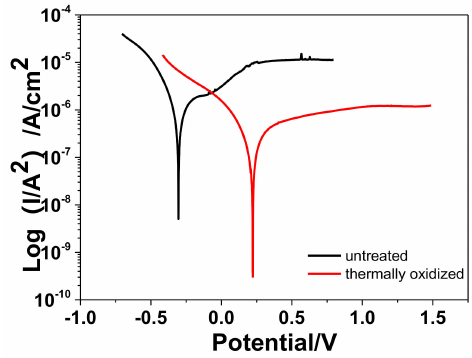
Figure 3. Potentiodynamic polarization curves of untreated and thermally oxidized samples. Sweep rate of 1 mV · s − 1 , electrolyte: 0.9 wt.% NaCl